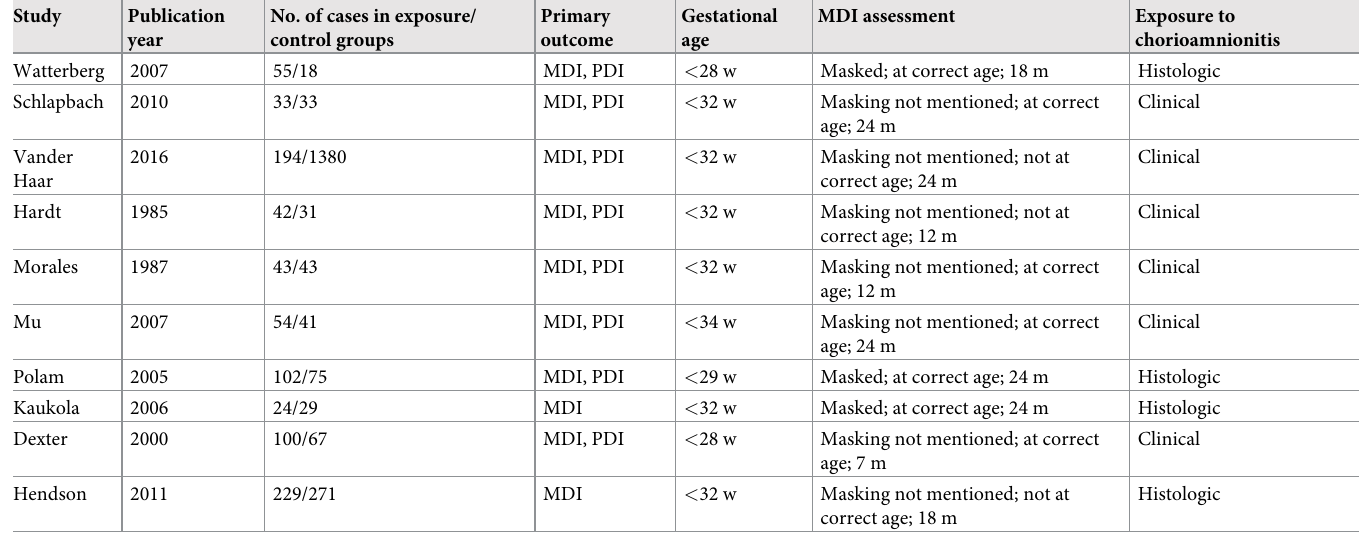
Table 1. Characteristics of the included